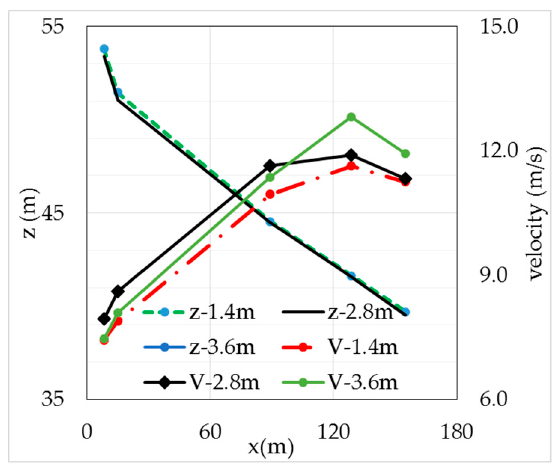
Figure 23. Water elevation and velocity profiles at five gauges.